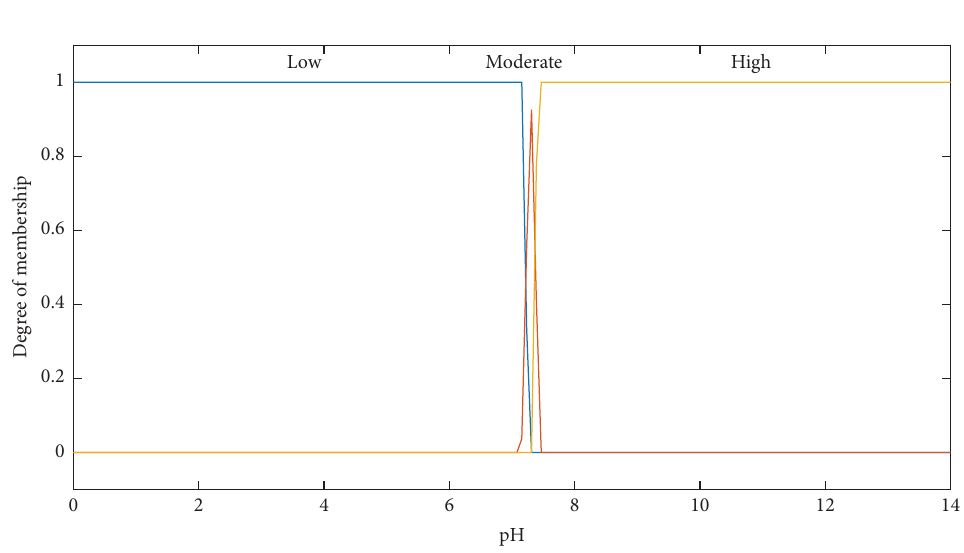
Figure 11: Membership function for low PEEP input.